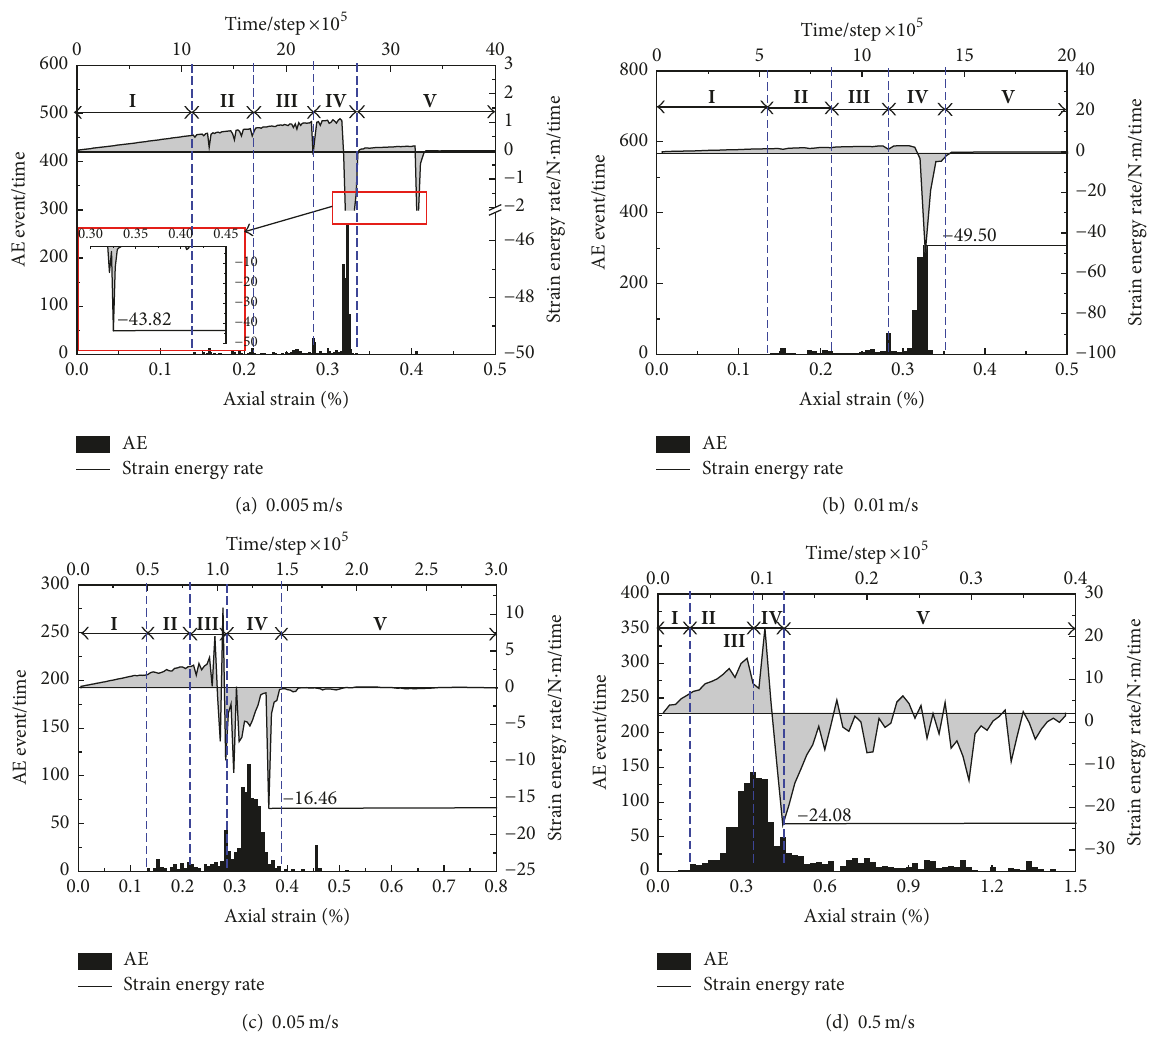
Figure 10: Curves of the axial stress-strain and acoustic emission frequency of the bonded particle